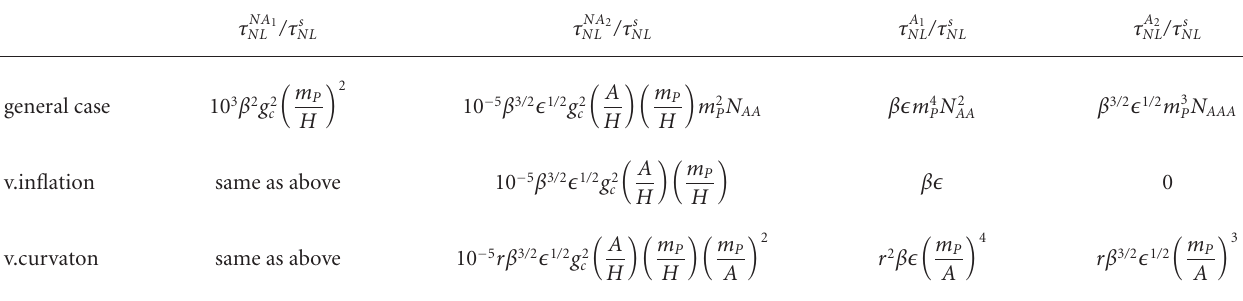
in di ff erent scenarios. /τ s NL NL